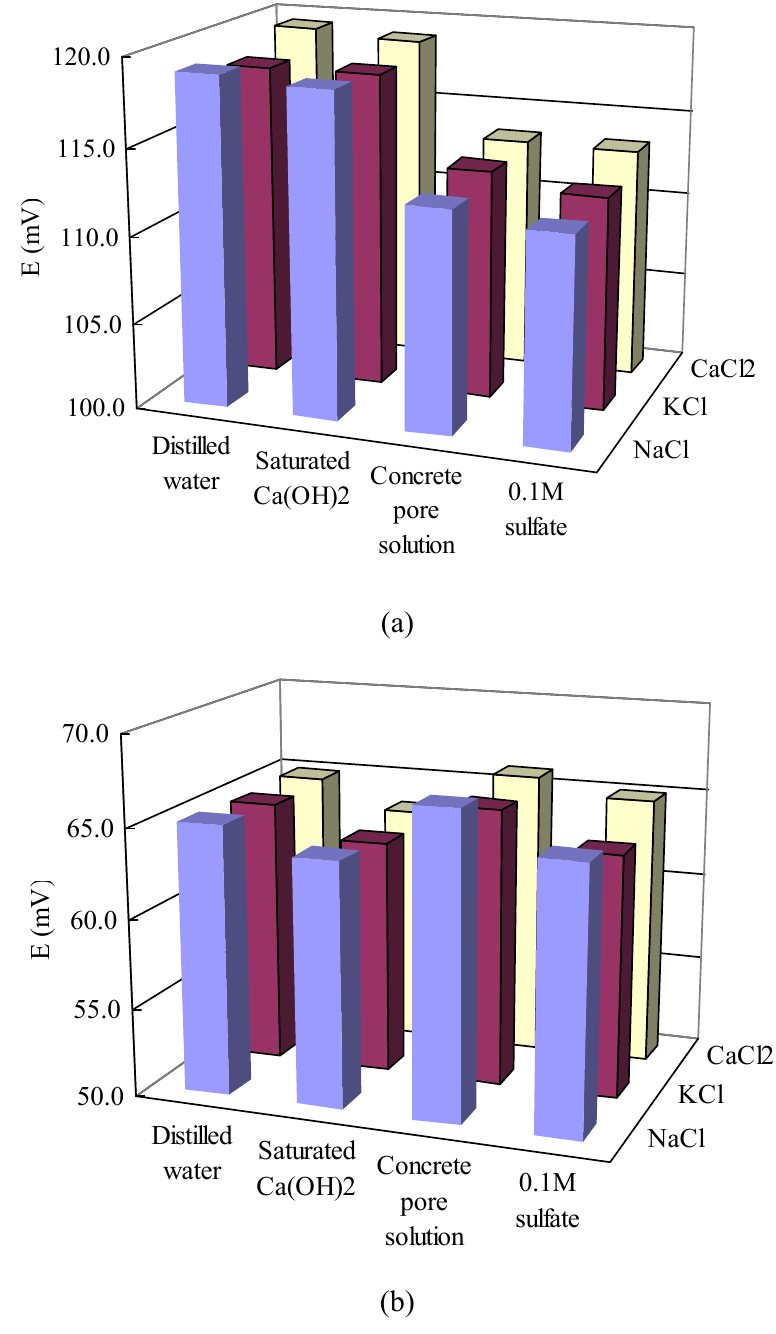
Figure 3. (a) Potentiometric responses of the sensor in different chloride solutions with 0.1 mol/L concentration of Cl − . (b) Potentiometric responses of the sensor in different chloride solutions with 1.0 mol/L concentration of Cl −